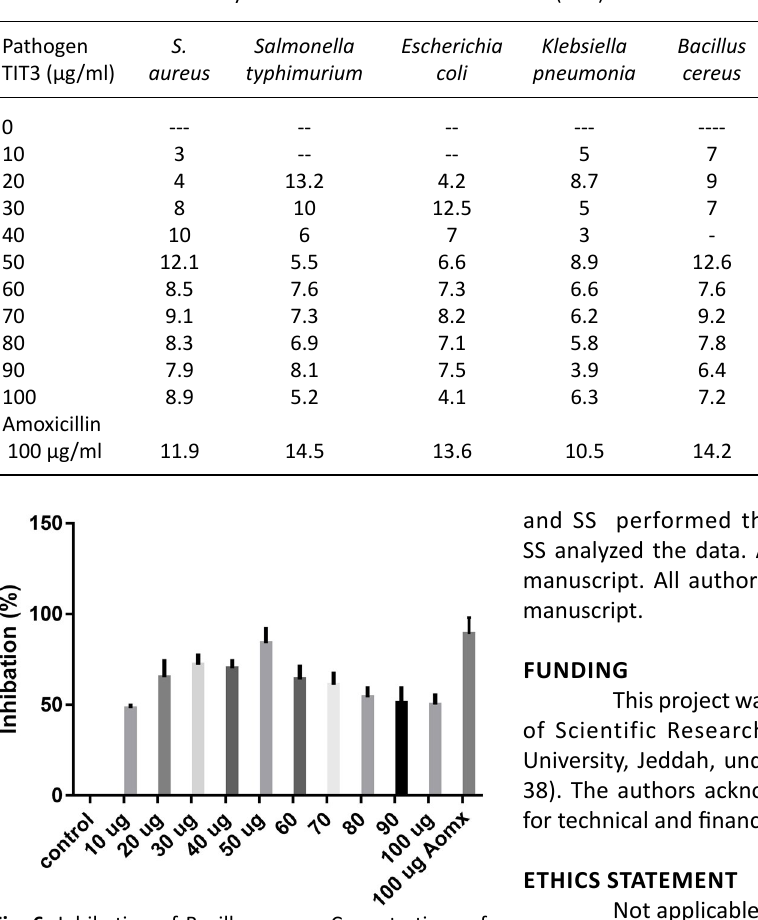
Fig. 6. Inhibation of Bacillus cereus Conentrations of TIT3 (ug)